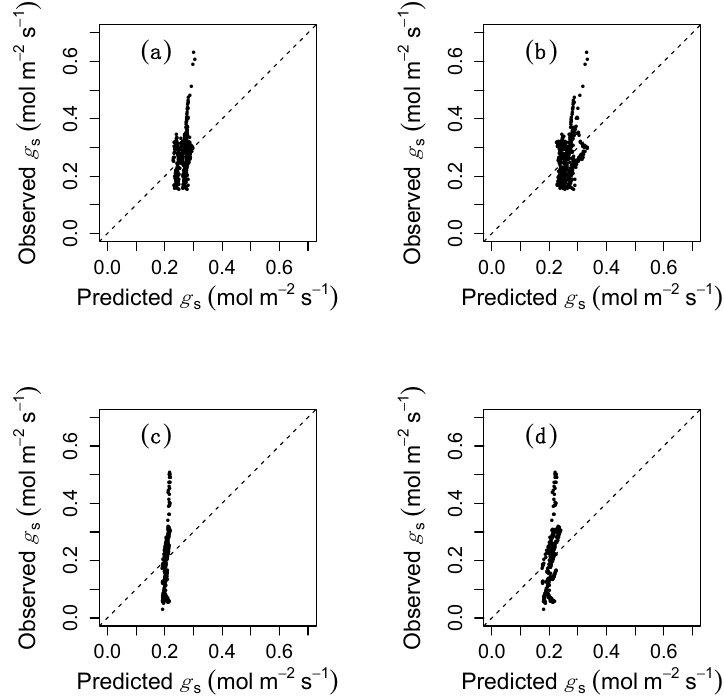
Figure 3. Results of model fitting. Observed vs. predicted values of g s for bean ( a , b ) and cotton ( c , d ) under the hypotheses that stomata operate to optimize water use efficiency ( a , c ) or to maximize carbon assimilation ( b , d ).